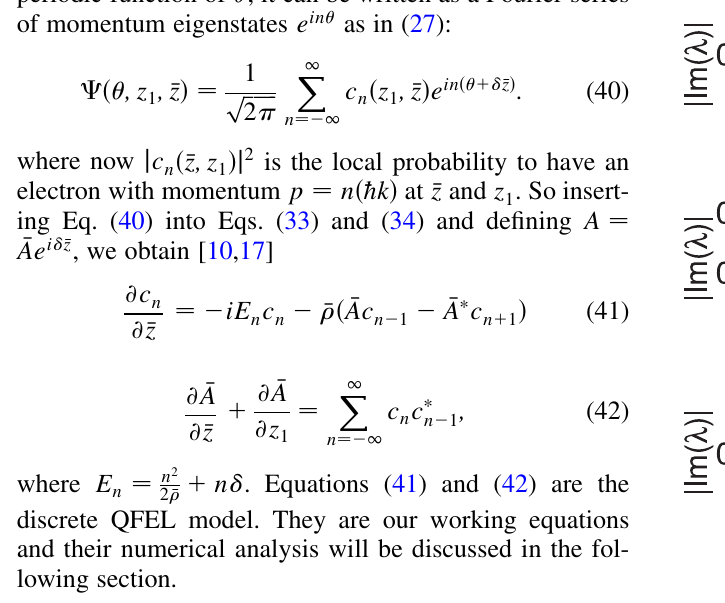
FIG. 2. Imaginary part of the unstable root of the cubic Eq. (43) vs (cid:1) ! (cid:1) (cid:5) ! 0 (cid:6) ! (cid:7) = (cid:5) 2 (cid:1)! (cid:7) for (cid:5) (cid:1) 0 , (a) (cid:1) (cid:1) (cid:1) 0 : 1 , (b) (cid:1) (cid:1) (cid:1) 0 : 2 , and (c) (cid:1) (cid:1) (cid:1) 0 : 4 . Each line is centered around (cid:1) ! (cid:1) p (cid:5) 2 n (cid:6) 1 (cid:7) = (cid:5) 2 (cid:1) (cid:1) (cid:7) and has a width 4 (cid:3)(cid:3)(cid:3)(cid:3) (cid:1) (cid:1) . For (cid:1) (cid:1) > 0 : 4 , the lines overlap and the spectrum becomes